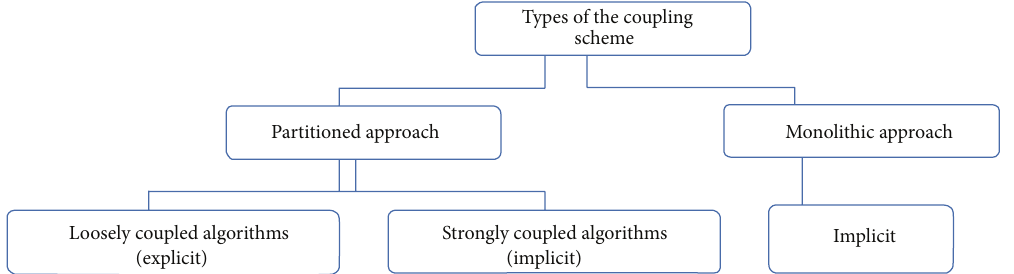
Figure 2: Coupling schemes in solving fluid structure interaction problems.